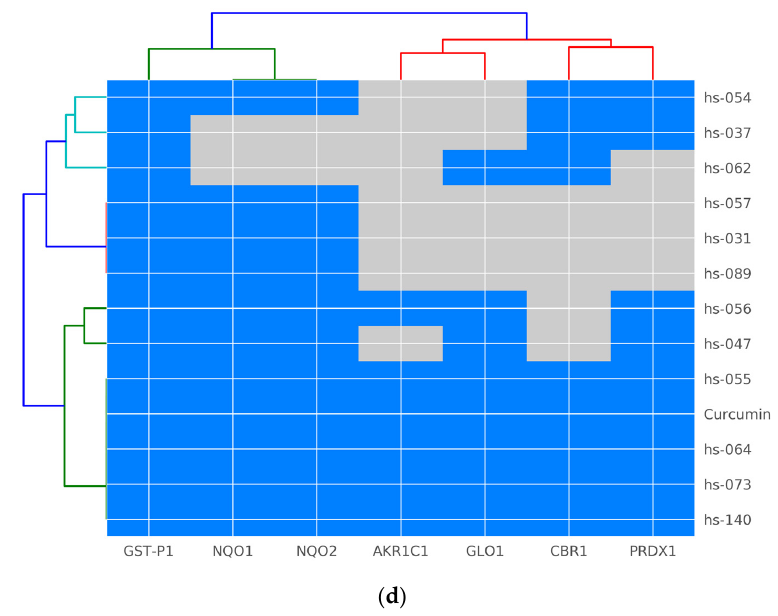
Figure 6. Binding of curcumin derivatives to ROS metabolic enzymes. ( a , b ) Control, curcumin, and curcumin derivatives beads were subjected to a pull-down assay using cell lysates containing HA-CBR1, HA-GSTP1, HA-PRDX1, HA-NQO1, HA-AKR1C1, HA-NQO2, and HA-GLO1 proteins ( a ). Bound proteins were visualized by immunoblotting, using an anti-HA antibody ( b ). ( c ) Summary of the results of panel b. The positive combination is marked as O. ( d ) Heatmap of the binding result shown in panel c. The dendrograms on the top and left of the heatmap indicate the hierarchical clustering of the target proteins and derivatives, respectively.